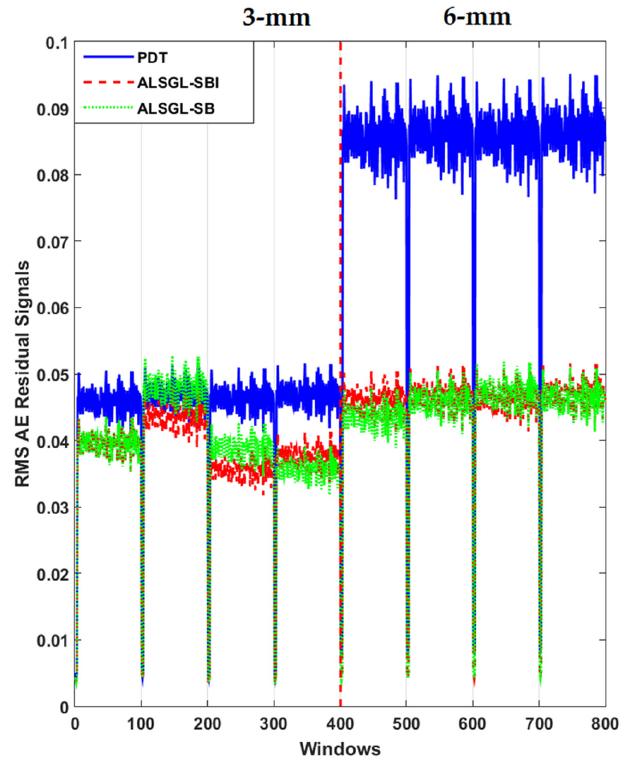
Figure 19. RMS of resampled AE residual signals for crack size (3 mm and 6 mm) diagnosis for outer conditions using ALSGL-SB, ALSGL-SBI and PDT methods.